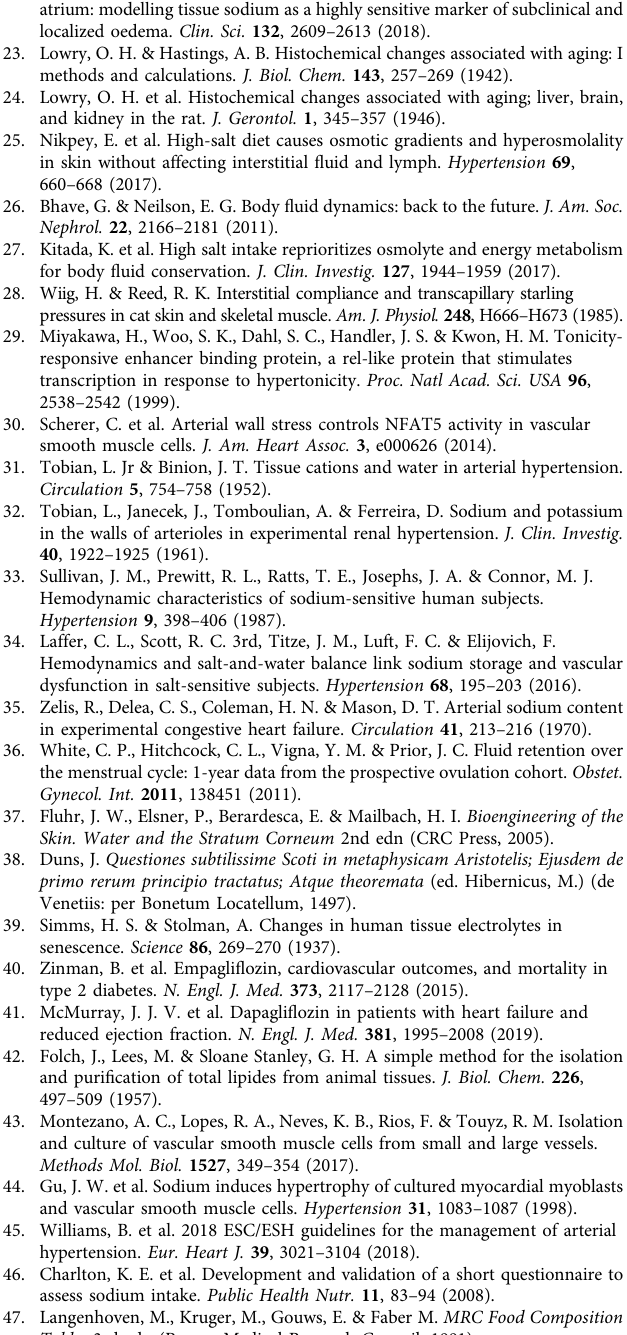
fi gures. Regression curves were derived by least-square method and compared by Extra sum-of-squares F test; for vascular function analysis, maximal